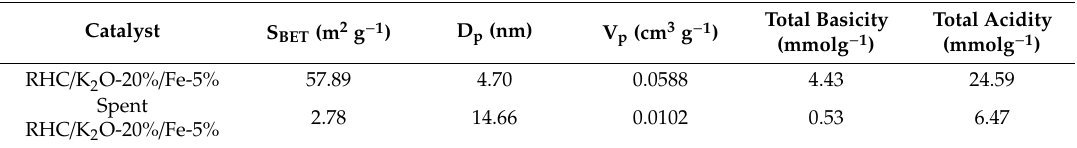
Table2. TexturalpropertiesandtotalCO 2 , NH 3 desorptionoffreshnano-magneticRHC / K 2 O-20% / Fe-5% and spent nano-magnetic RHC / K 2 O-20% /